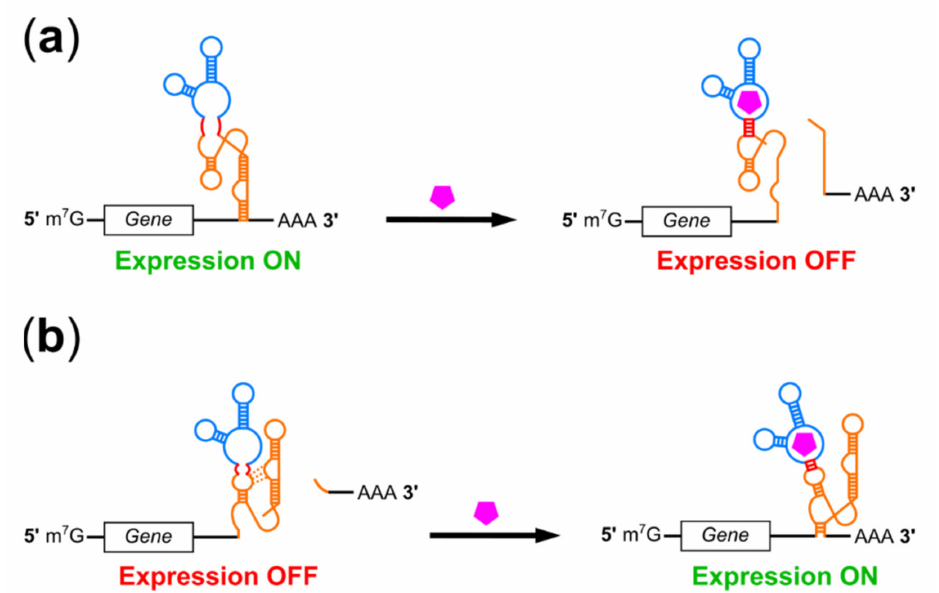
Figure 4. Aptazyme Riboswitches. ( a ) Aptazyme off-switches. An aptazyme consists of a self- cleaving ribozyme (orange) connected to an aptamer (blue) by a short CM (red). Ribozyme domains are inactive in the absence of ligand. Ligand binding (magenta) promotes CM annealing, which activates ribozyme cleavage and suppresses expression [130,131,137]. ( b ) Aptazyme on-switches. Self-cleavage is constitutively active in aptazyme on-switches, and is inhibited by ligand binding to promote gene expression